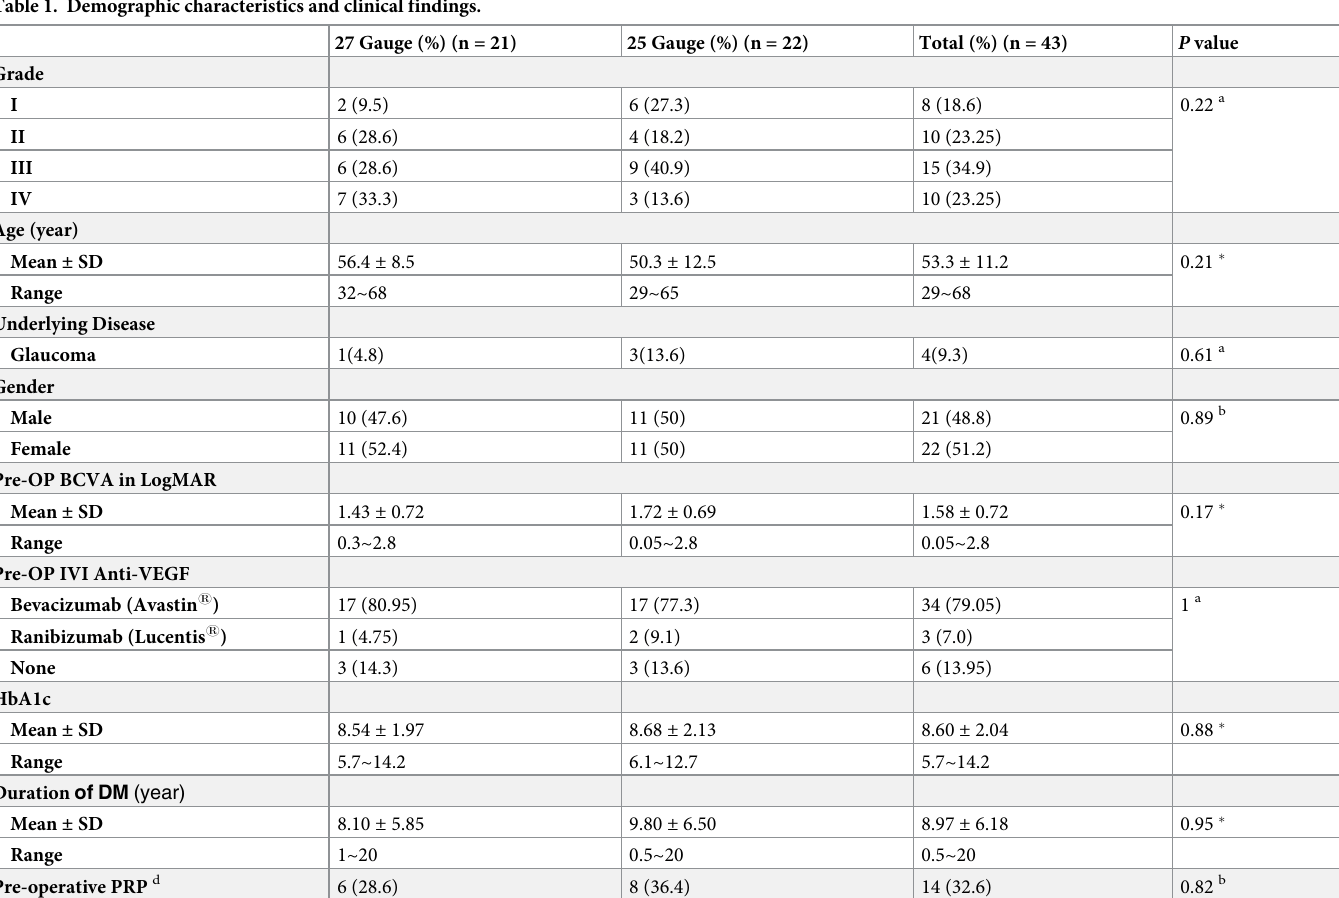
Table 1. Demographic characteristics and clinical findings.